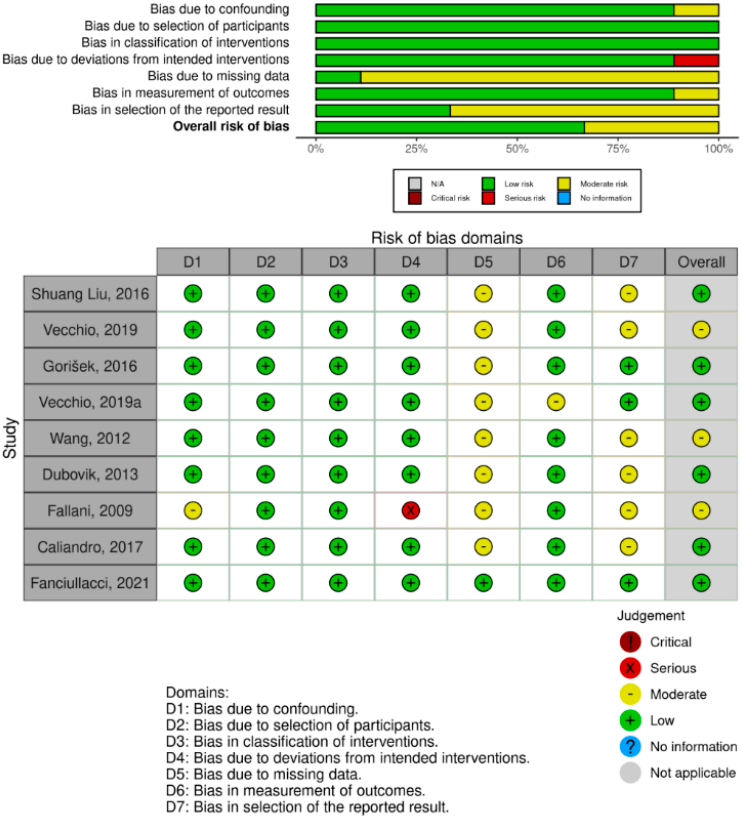
Figure 2. Risk of bias (RoB) traffic light plot. Assessment of the risk of bias via the traffic light plot of the RoB of each included clinical trial and the weighted plot for the assessment of the overall risk of bias via the Cochrane Robins-I tool ( n = 9 studies). Yellow circle indicates some concerns on the risk of bias, and green circle represents low risk of bias [4–10,12,13].